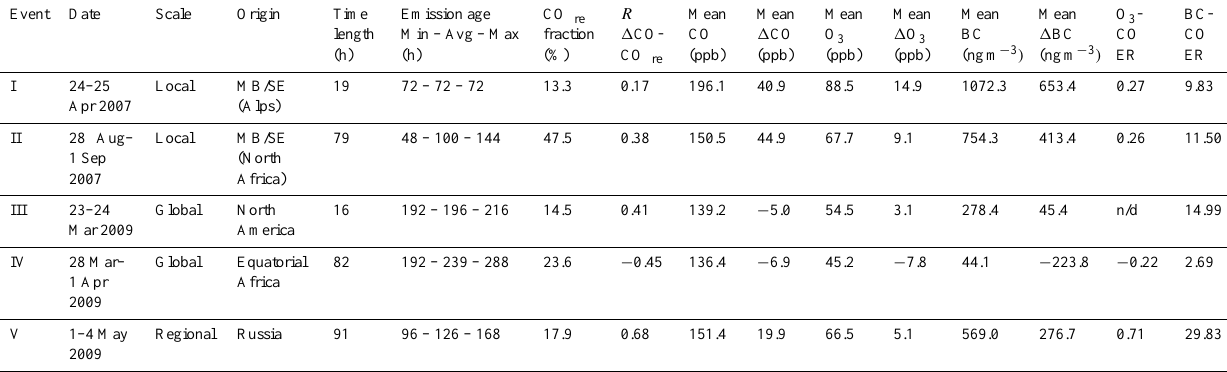
Table 1. List of the five “representative” BB events at ICO-OV as deduced by FLEXPART analyses. For each event we reported: start and end dates (“Date”), transport-scale (“Scale”), the emission region (“Origin”), the range (minimum, mean and maximum values) of representative emission ages during the event (“Emission age”), the averaged fraction of FLEXPART CO fire contribution (“CO fire fraction”), the linear correlation coefficient between 1 CO and CO fire (“ R ”), the mean CO and 1 CO at ICO-OV (“Mean CO”; “Mean 1 CO”), the mean O 3 and 1 O 3 at ICO-OV (“Mean O 3 ”; “Mean O 3 ”), the mean BC and 1 BC at ICO-OV (“Mean BC”; “Mean BC”), the calculated O 3 -CO and BC-CO enhancement ratios (“O 3 -CO ER”; “BC-CO